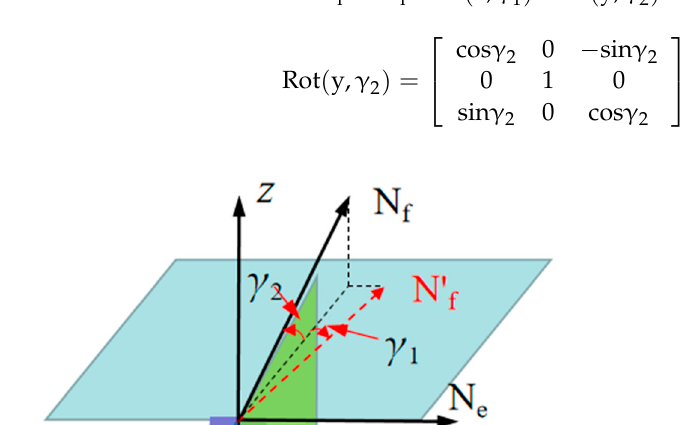
system. These measuring instruments have certain errors, which leads to the initial tracking position of the SDC system not being due east. Therefore, this section takes a typical day (the summer solstice) in a typical area (Dunhuang) as an example to study the influence of the initial tracking position of an SDC system on its tracking performance under the azimuth axis tilt error. Figure 6 shows the schematic diagram of the initial tracking position of an SDC system. In order to describe the initial tracking position of an SDC system, two offset angles, γ 1 and γ 2 , are introduced. Then, any initial tracking position can be considered as the focal axis vector rotated by γ 1 around the z-axis and then rotated by γ 2 around the y-axis. The focal axis vector N’ f of the initial tracking position can be calculated by Equation (19), where Rot(y, γ 2 ) and Rot(z, γ 1 ), respectively, represent the rotation matrix around the y- and z-axes, which are shown by Equations (3) and (20), respectively. When (cid:54) = 0 and γ γ 1 2 = 0, the initial tracking position varies in the horizontal plane. When and γ 2 (cid:54) = 0, the initial tracking position varies in the vertical plane. When γ 1 = γ 2 = 0, it means that the initial tracking position of the SDC system is due east. The value range of − 0.5 ◦ , 0.5 ◦ ]. γ γ 1 and 2 is [